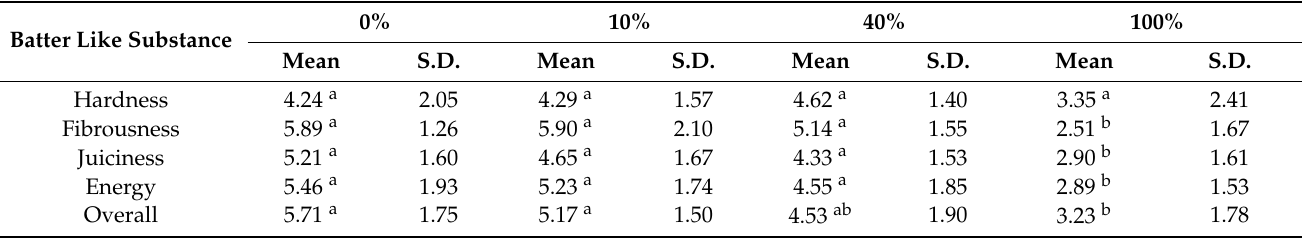
Table 2. Sensory scores for selected attributes on a scale from 0 to 10, with 5 as reference value. 0 = worst, 10 =